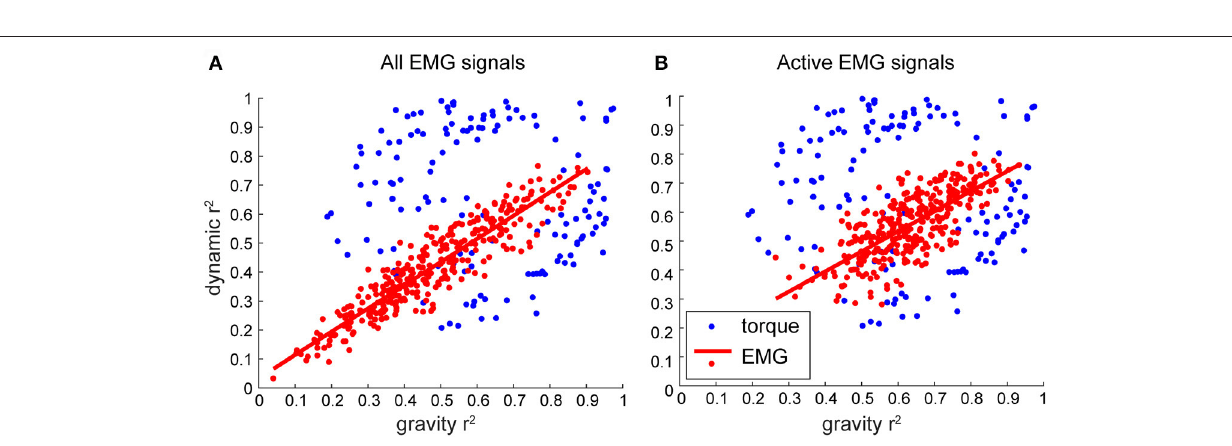
FIGURE 7 | The relative contribution of individual components to EMG and muscle torques across subjects. Each dot represents a value per subject per movement averaged across signals/DOFs. (A) Combined data across subjects. (B) Combined data across subjects, where only variance for conditions when EMG was active > 30% of maximal was selected before averaging.